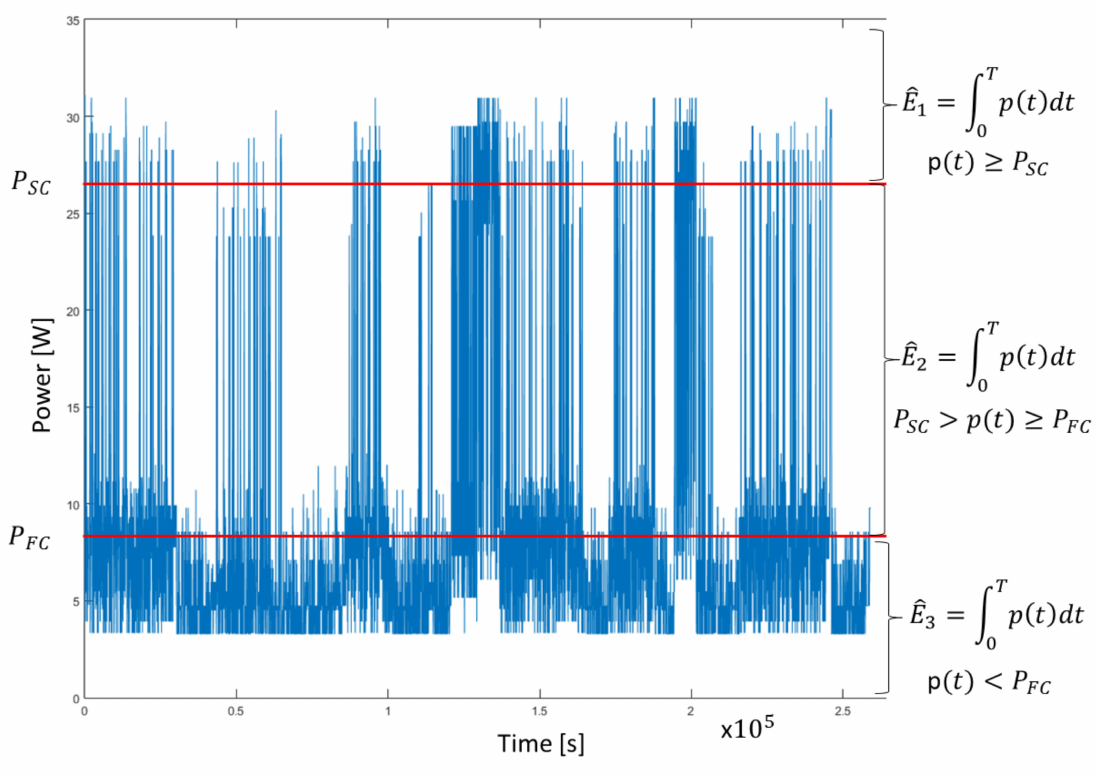
Figure 1. The energy profile generated in the random mode, with the marked power level and energy gathered in each threshold. P SC stands for the power level at which supercapacitor starts to work in normal conditions, and P FC stands for the power level at which the fuel cell starts to work in normal